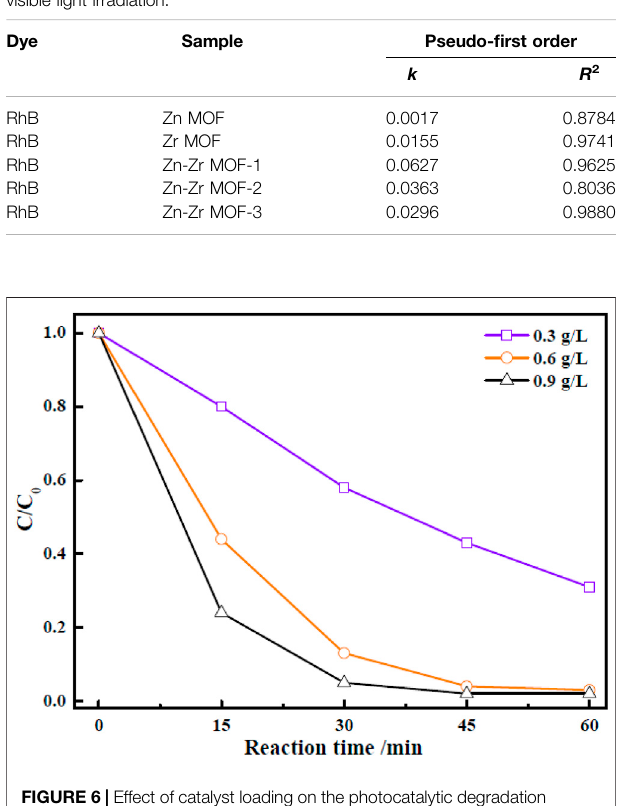
FIGURE 6 | Effect of catalyst loading on the photocatalytic degradation of RhB under visible light irradiation.